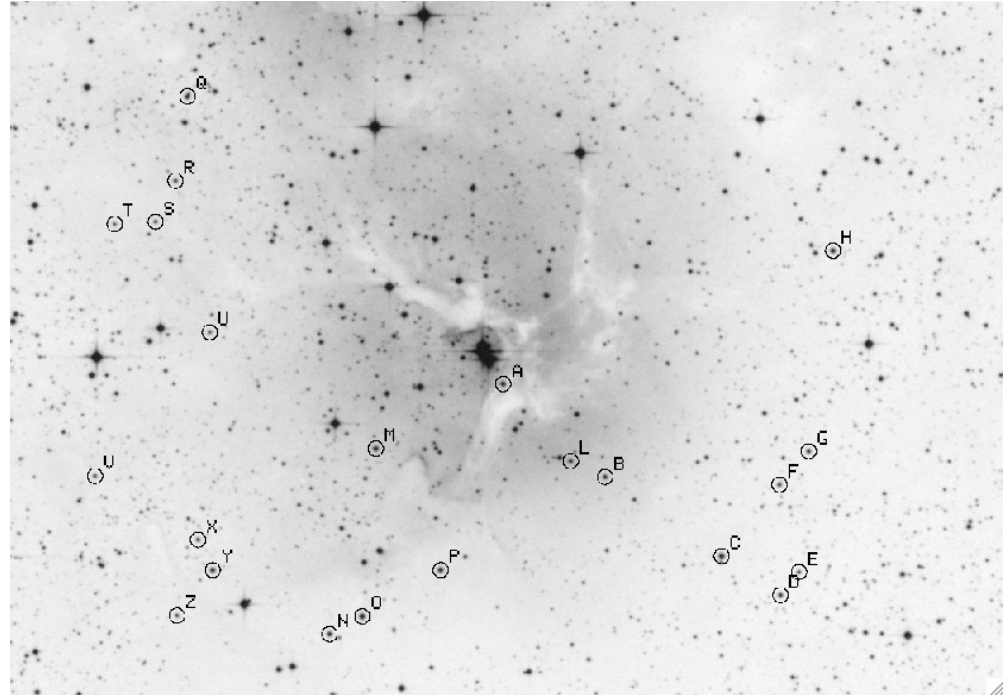
Figure 1: Finding chart of V2282 Sgr from a POSS II plate with IV-N emulsion. The variable is marked with L. Comparison stars are labelled. The field is 12 arcmin wide in DEC, North is up and East to the left.